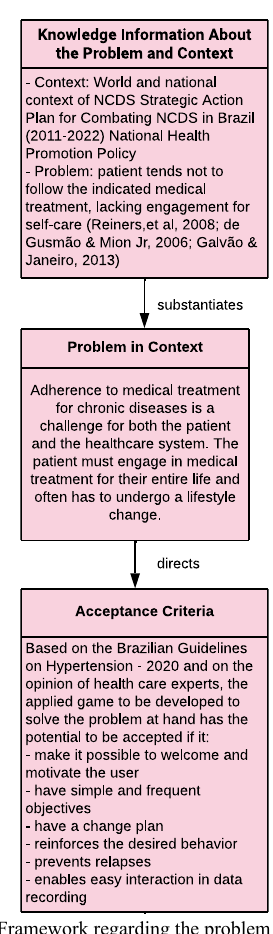
Figure 2. Framework regarding the problem and